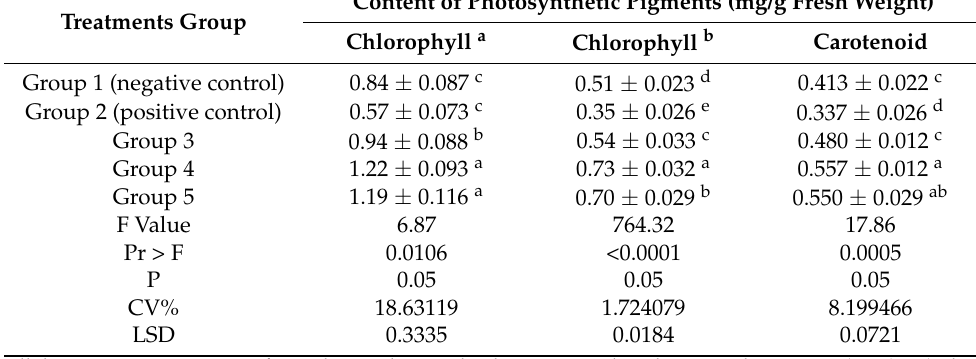
leaves of the coffee seedlings grown under greenhouse